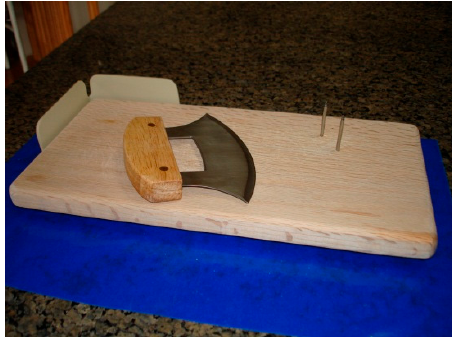
Figure 4. Life started to become normal with an ulu knife and nails in a cutting board.